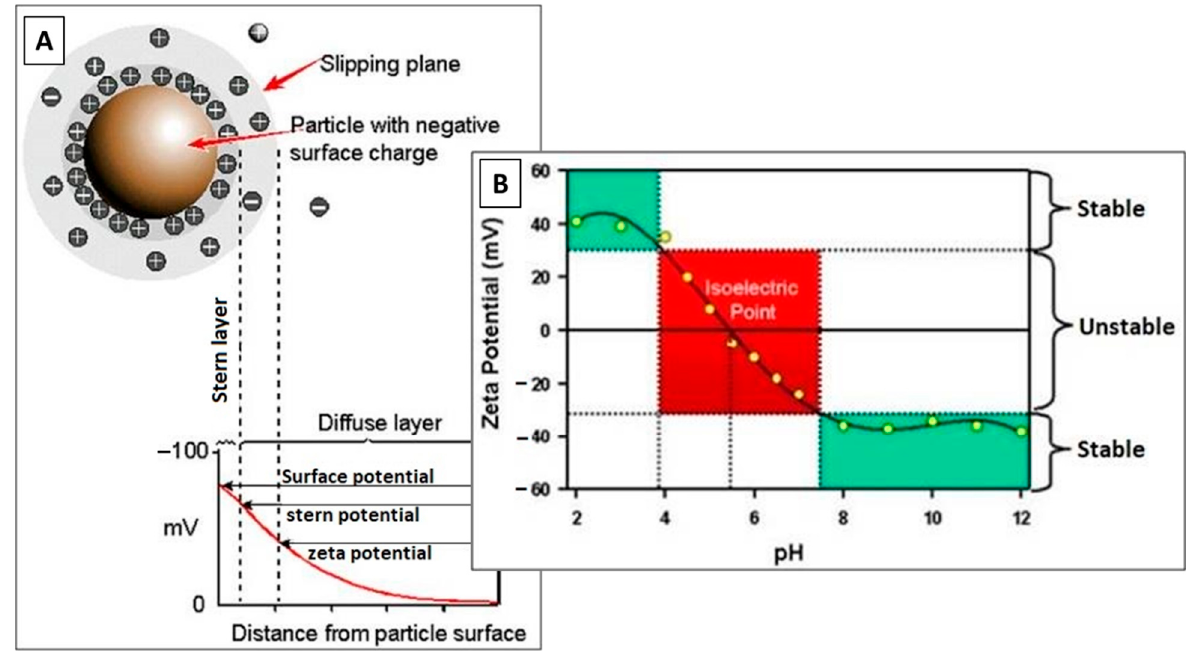
Figure 3. ( A ) Schematic representing Zeta potential, and ( B ) zeta potential vs. pH plot showing the values of conditions on which stable or unstable suspension will form. Reproduced from [52].